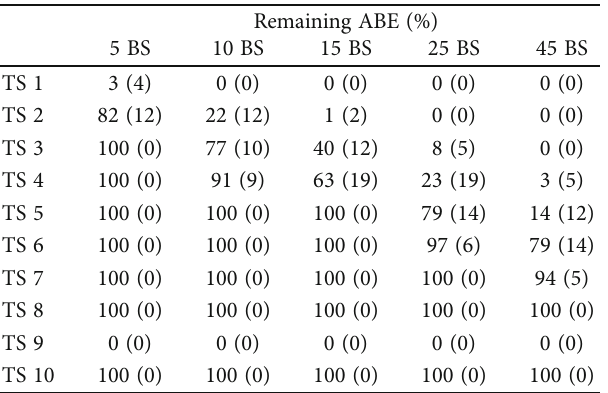
Figure 1: In fl uence of brushing strokes (BS) and mixing ratio on the percentage of remaining arti fi cial bio fi lm equivalent (ABE) in the test series TS 1 to TS 8 and control (TS 10). See also Table 2. The lines connecting data points are guides to the eye only. Table 2: Descriptive data (mean, brackets contain standard deviation) for the percentage of remaining arti fi cial bio fi lm equivalent (ABE) for test series 1 to 10 after brushing with 5 to 45 brushing